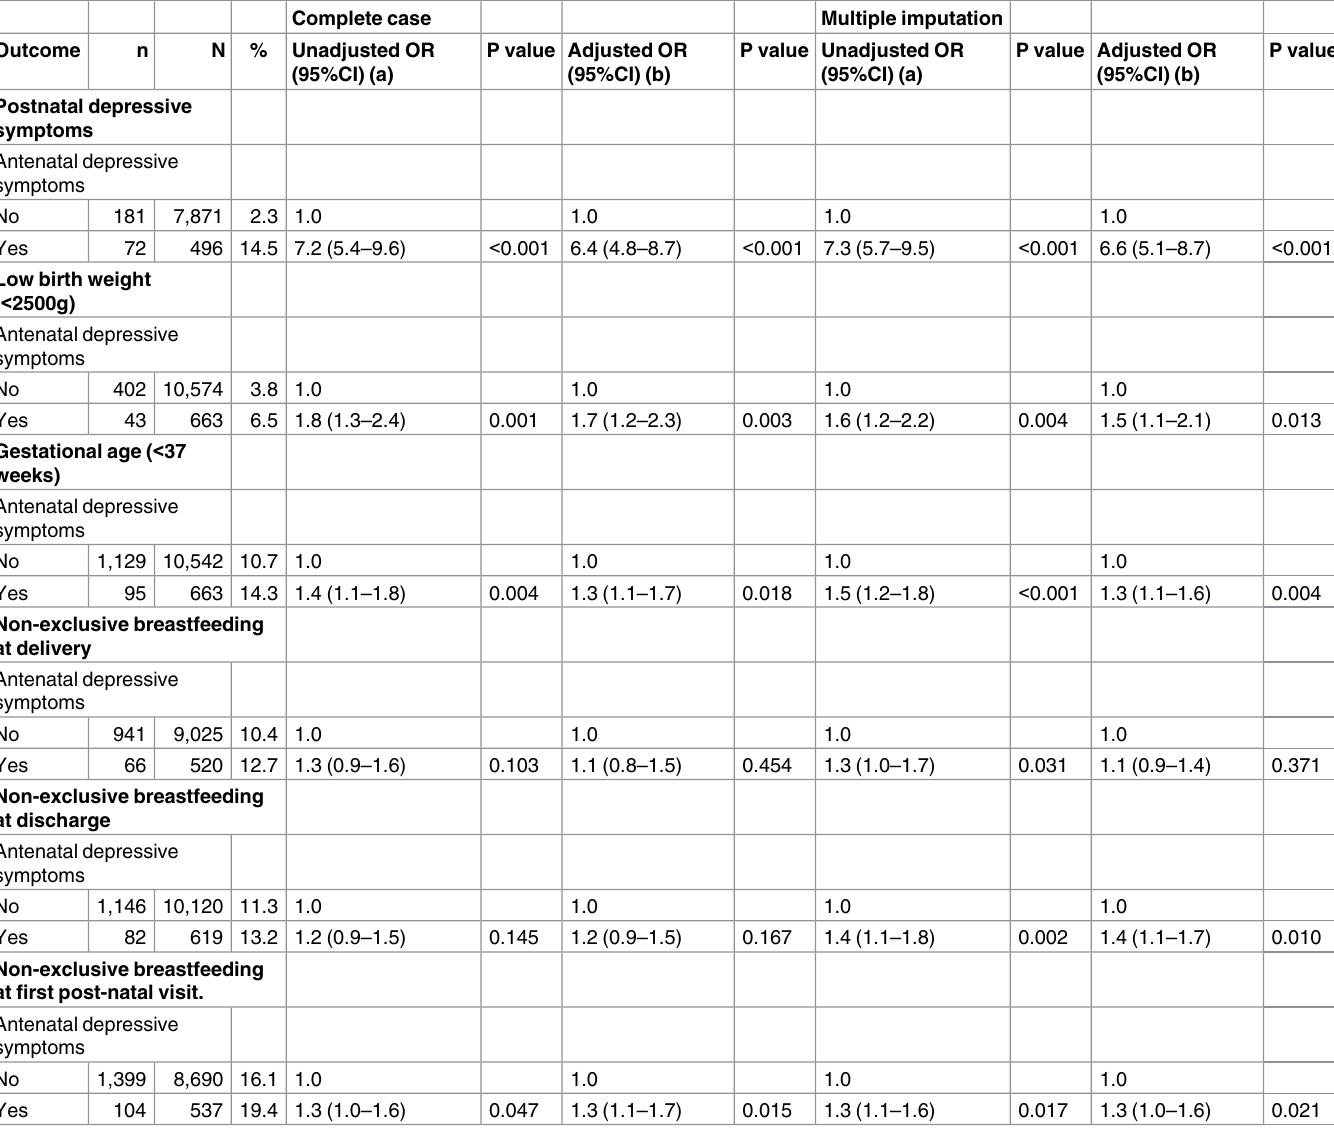
Table 3. Associations between antenatal depressivesymptoms and postnatal depressive symptoms, perinatal outcomes, and breast feeding behaviours of mothers of infants from South Western Sydney and Sydney Local Health Districts in 2014 (n = 17,564). Complete case